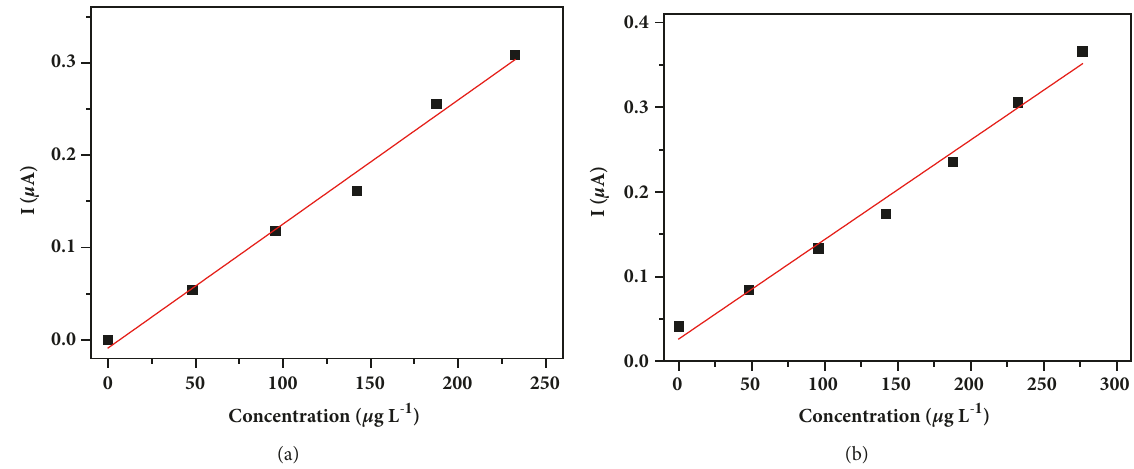
Figure 7: Calibration curves of standard addition method for Cd(II) (a) and Pb(II)